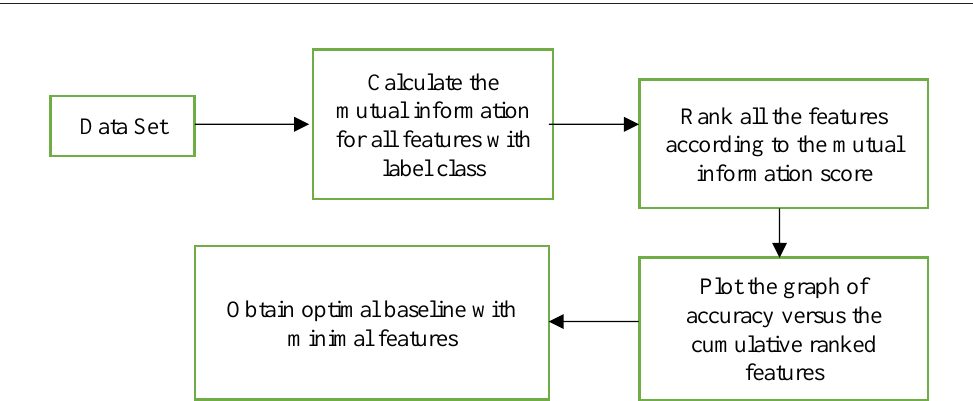
Fig 1. Flowchart of finding the optimal baseline and the unique cutoff number of